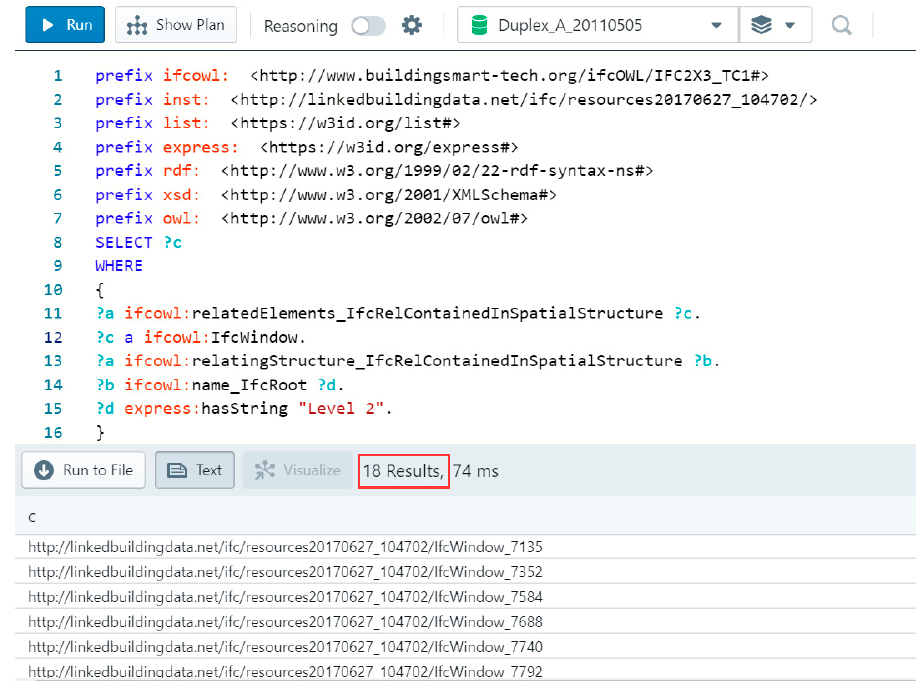
Figure 9. The generated SPARQL query and query results.